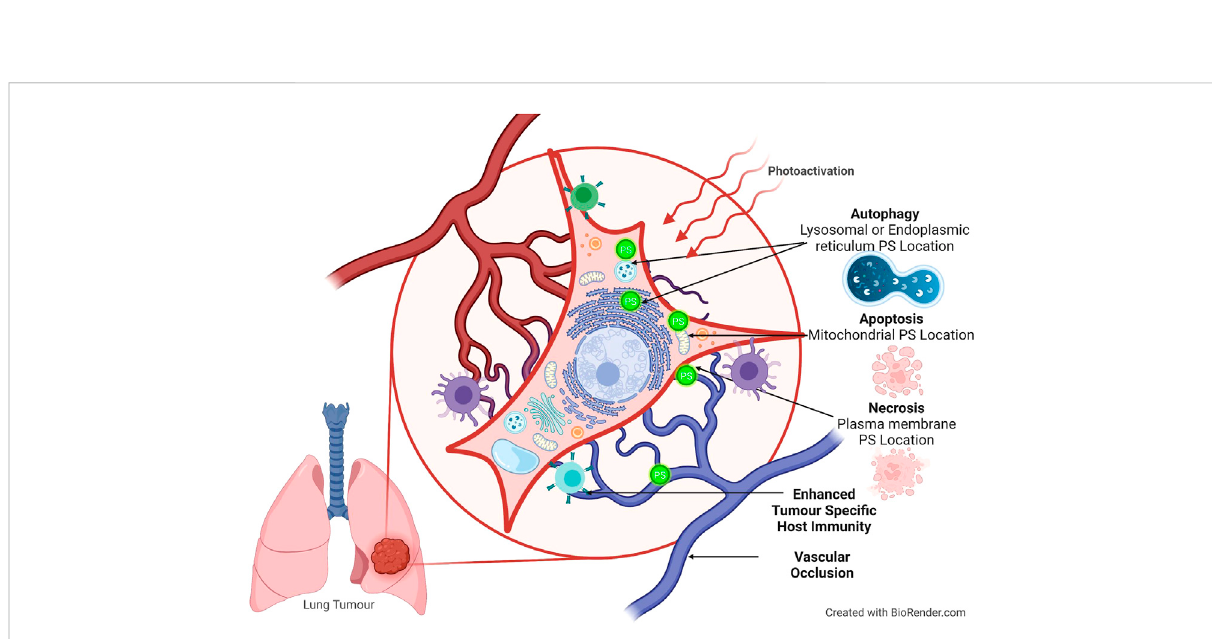
FIGURE 2 Cell death pathways activated during PDT, according to PS localization. The PS can localize in the cytoplasm and mitochondria and induce apoptosis. Autophagy occurs when there is damage to the lysosomes or endoplasmic reticulum. Necrosis occurs during plasma membrane